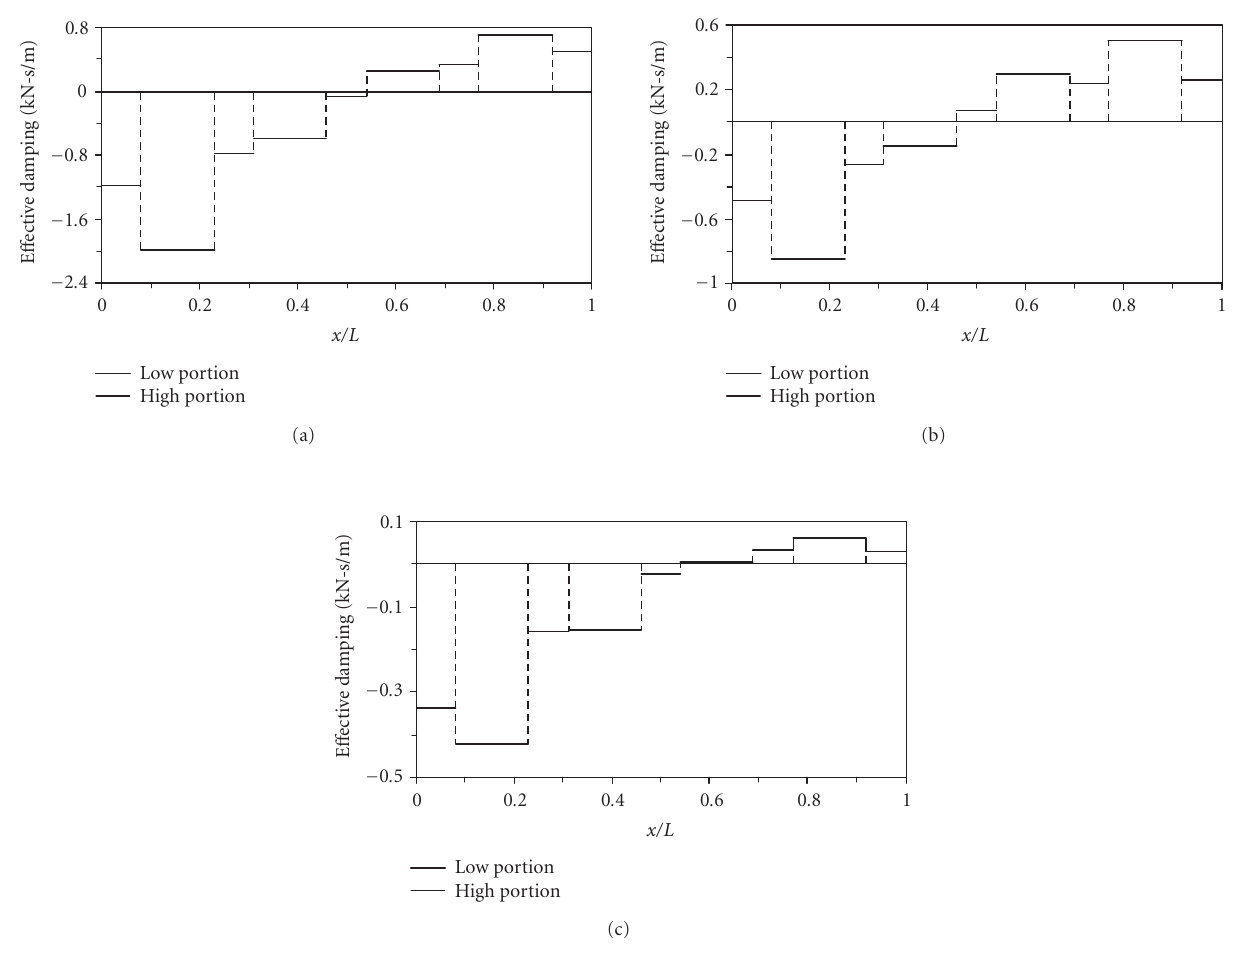
Figure 11: E ff ective damping distribution along the rotor surface for high-low seals at di ff erent relative axial rotor positions: (a) a/b = 0 . 0; (b) a/b = 0 . 5; (c) a/b = 1 .